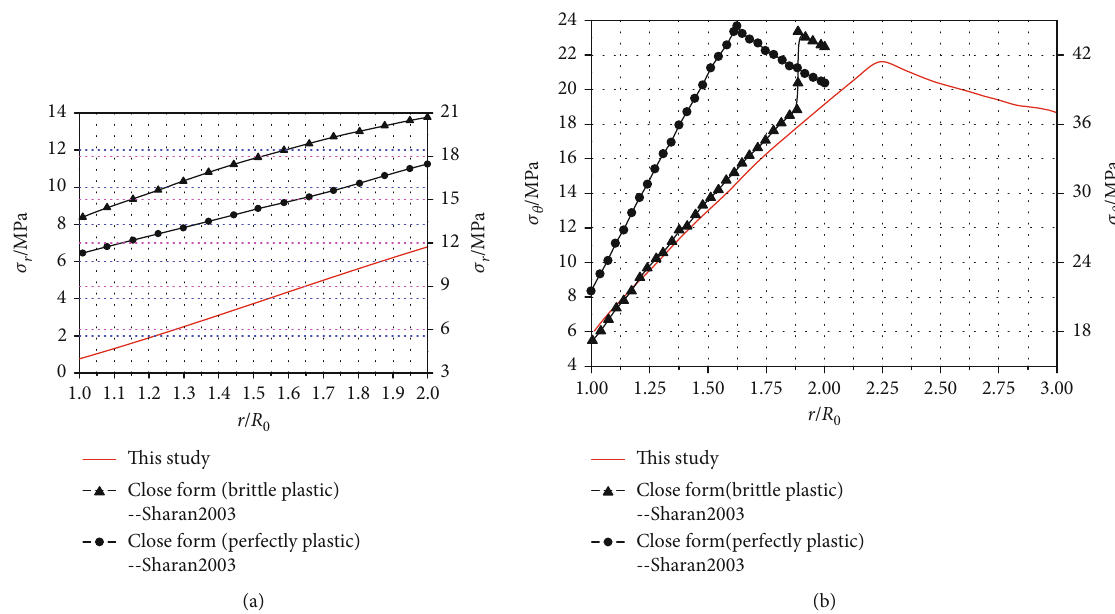
Figure 8: Comparison of stresses curves of GZZ criterion stress with narrow H-B criterion ((a) radial stress; (b) tangential stress).